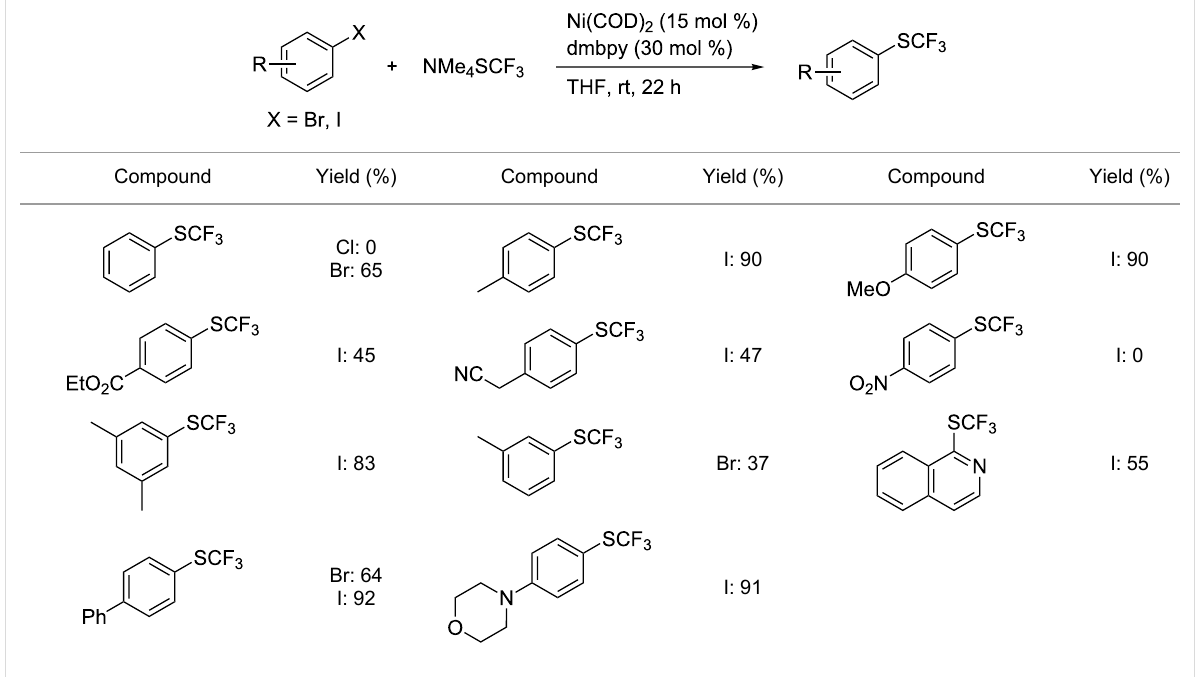
Table 48: Ni-catalyzed trifluoromethylthiolation of aryl halides with [NMe 4 ][SCF 3 ]